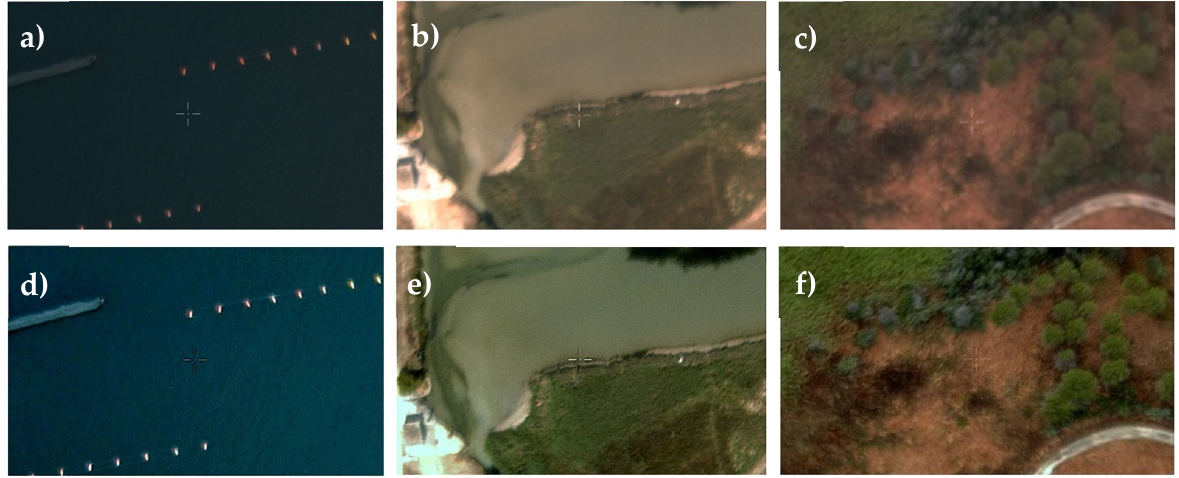
Figure 8. Image enhancement in three different environments: ( a – c ) the acquired image, ( d – f ) the same reworked image.